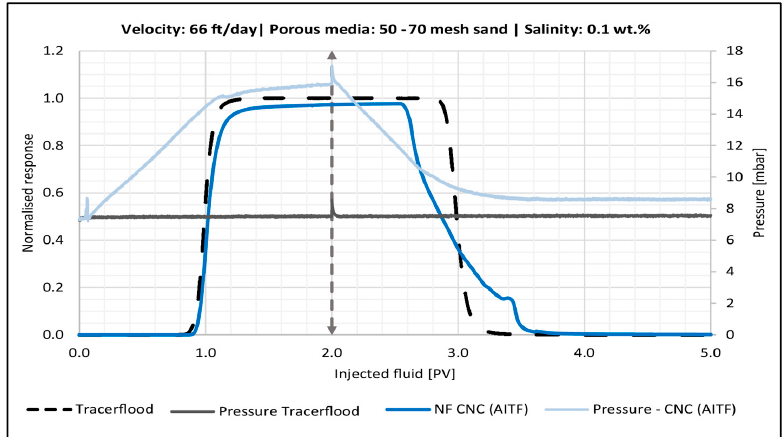
Figure 11. Breakthrough curve for the sandpack flood with 0.5 wt. % CNC (AITF) (dark blue line) using a medium velocity (66 ft/day). Dashed vertical line illustrates the switch to post flush fluid. The tracer BT-curve is the black dotted line. The corresponding pressure curves are also shown.